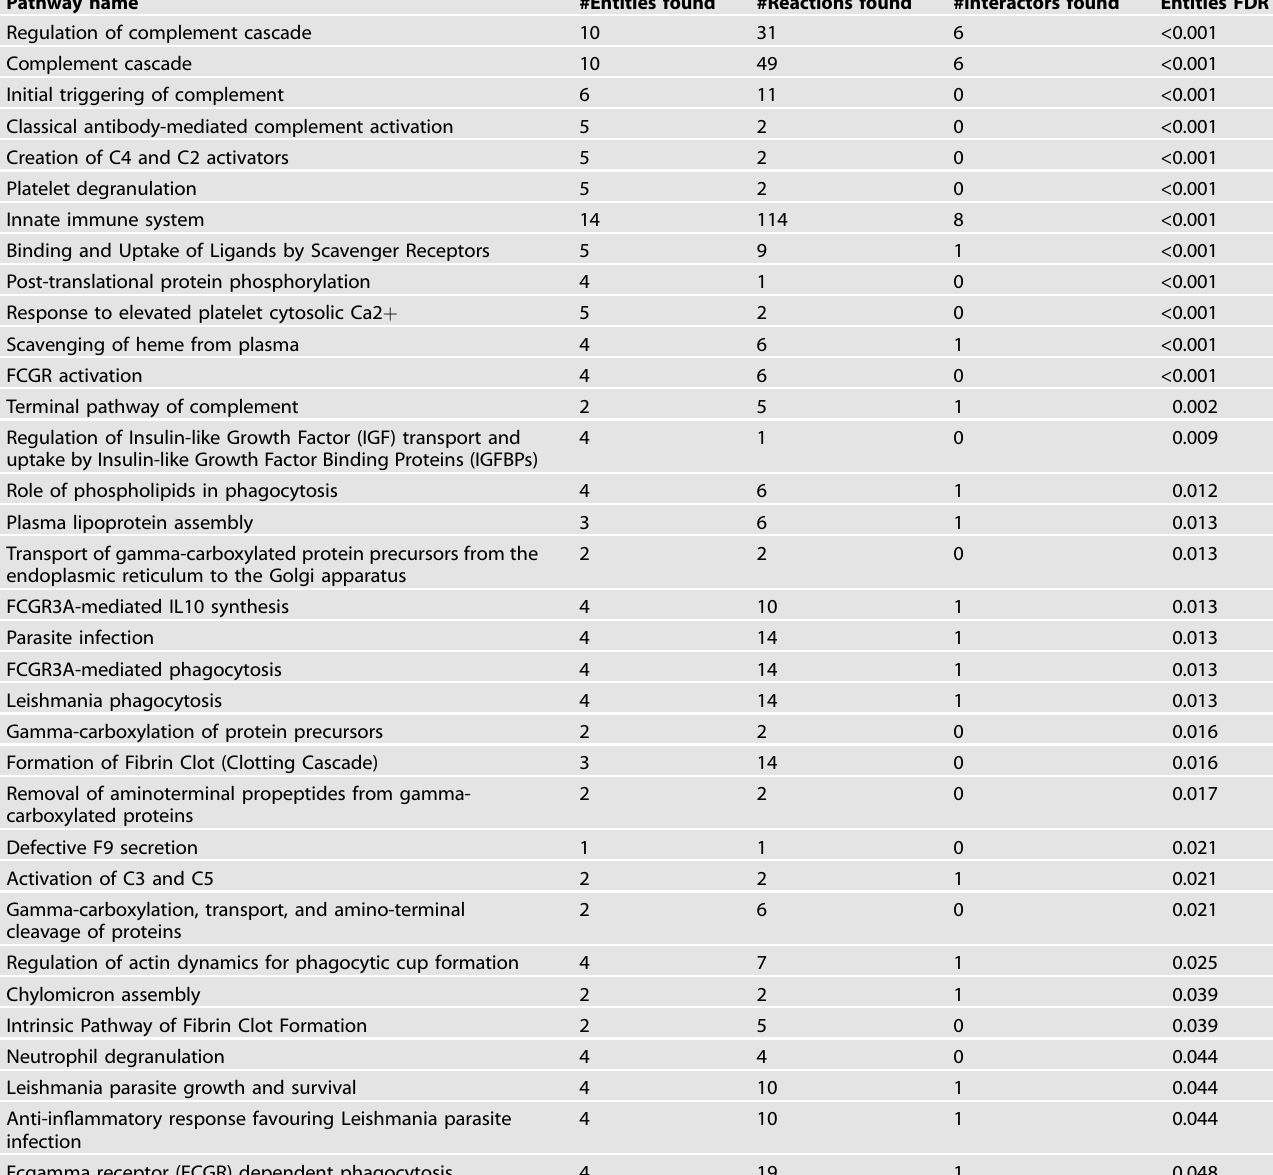
Table 2. Pathways signi fi cantly associated with 6-month change in total omega-3